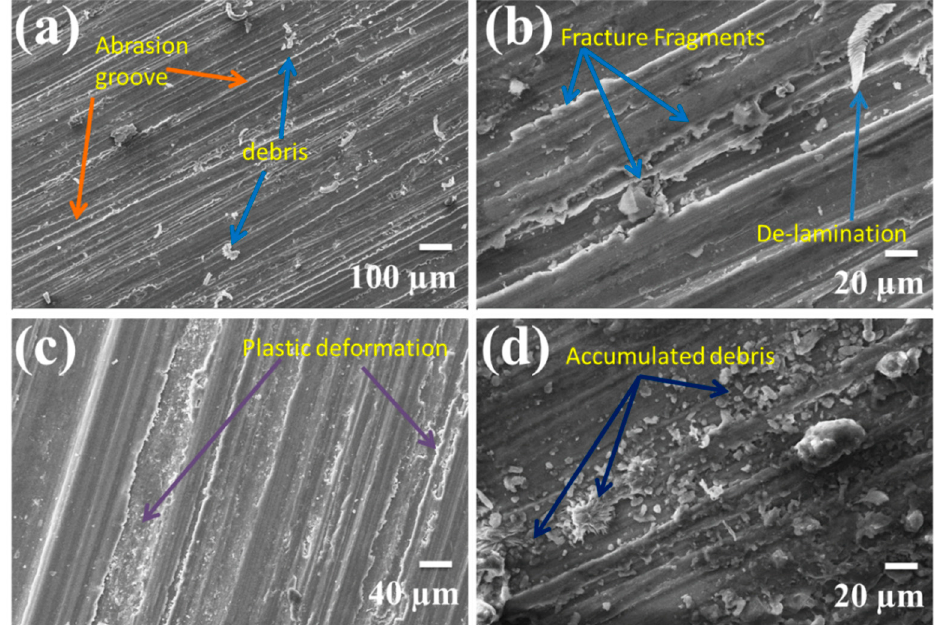
Figure 8. SEM micrographs of the worn surfaces of SiC reinforced AZ91 magnesium alloy composite: ( a ) 19.62 N, 2.6 m/s 3% SiC; ( b ) 39.24 N, 1.3 m/s and 6% SiC; ( c ) 58.86, 2.6 m/s 9% SiC; ( d ) 39.24 N, 2.6 m/s 12% SiC.